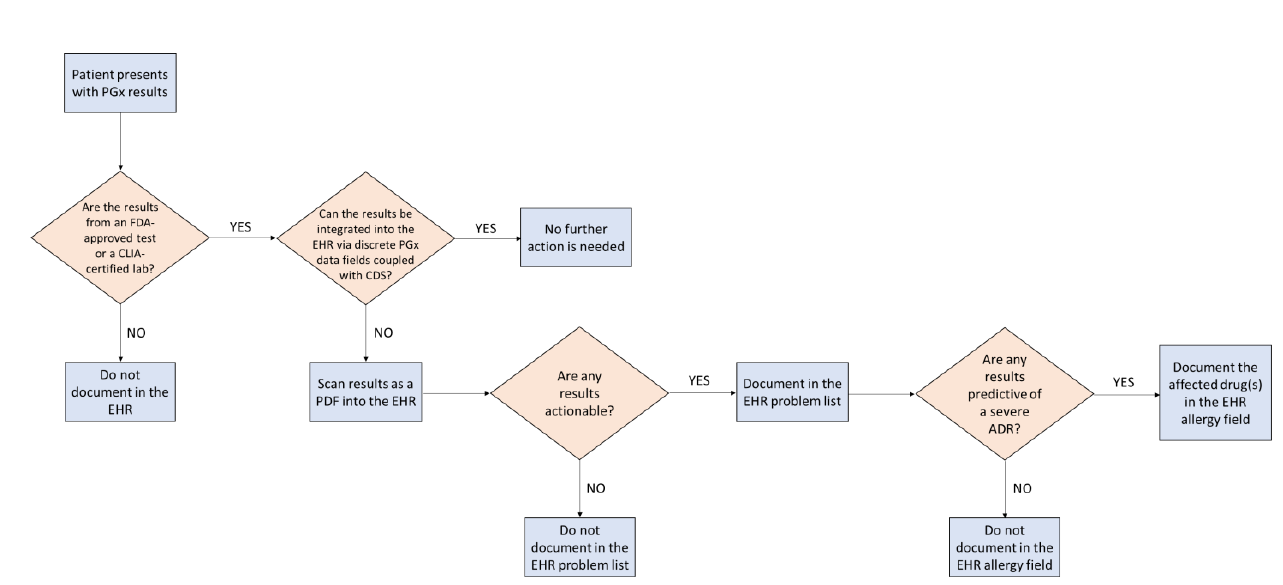
Figure 1. Decision-making process for documenting pharmacogenomic test results into electronic health records. ADR, adverse drug reaction; CDS, clinical decision support; CLIA, Clinical Laboratory Improvement Amendments; EHR, electronic health record; FDA, Food and Drug Administration; PGx, pharmacogenomics.